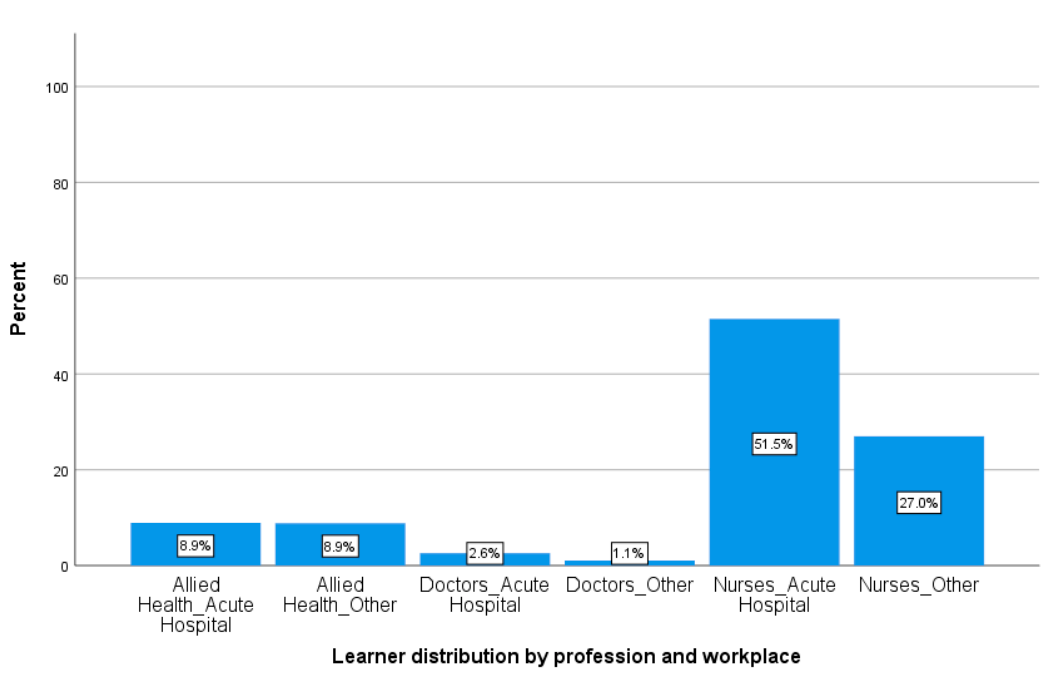
Figure 1. Learner distribution by profession and workplace ( n = 1489).